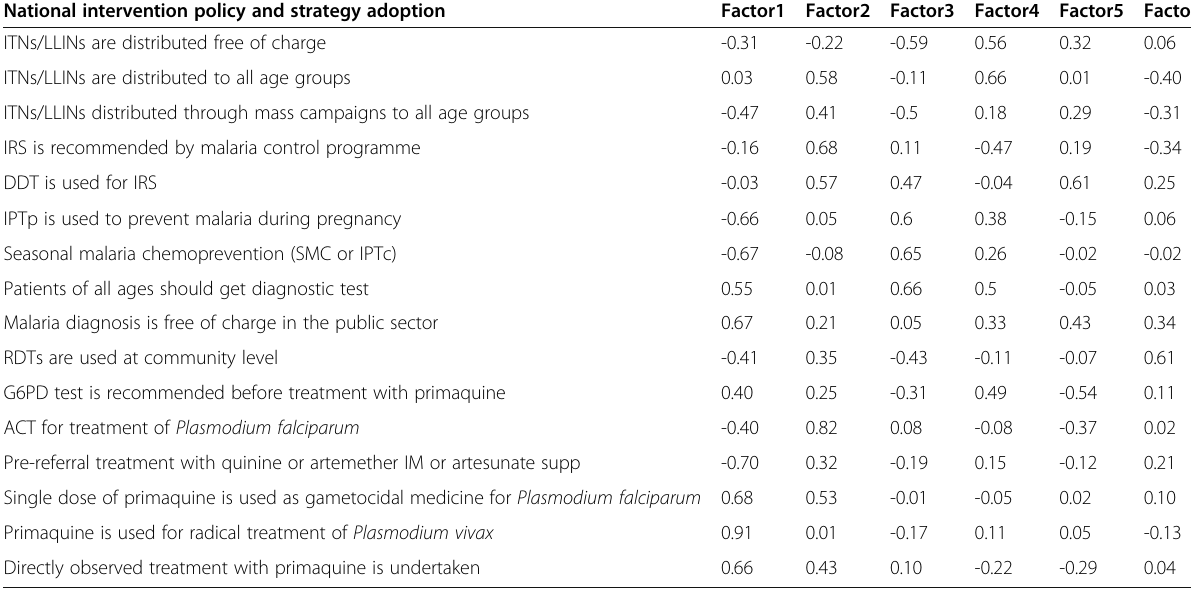
Table 5 National intervention policy and and strategy adoption with factor loadings National intervention policy and strategy